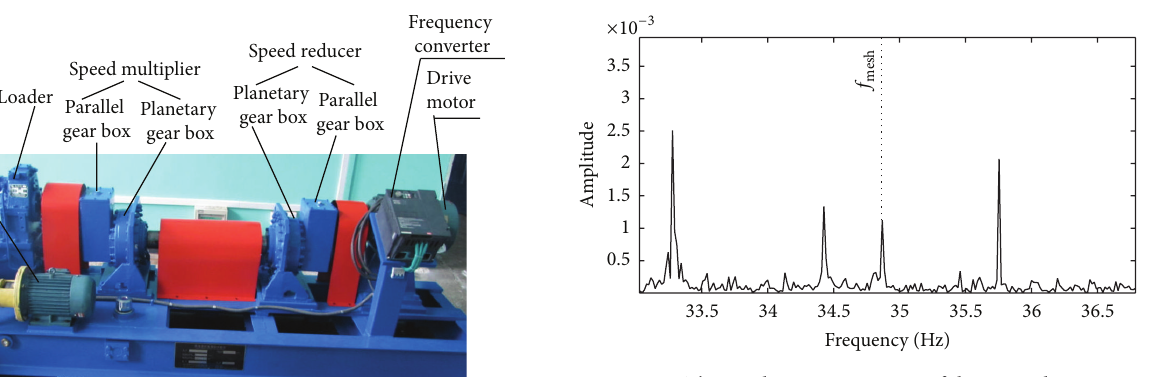
Figure 9: The acceleration spectrum of the normal